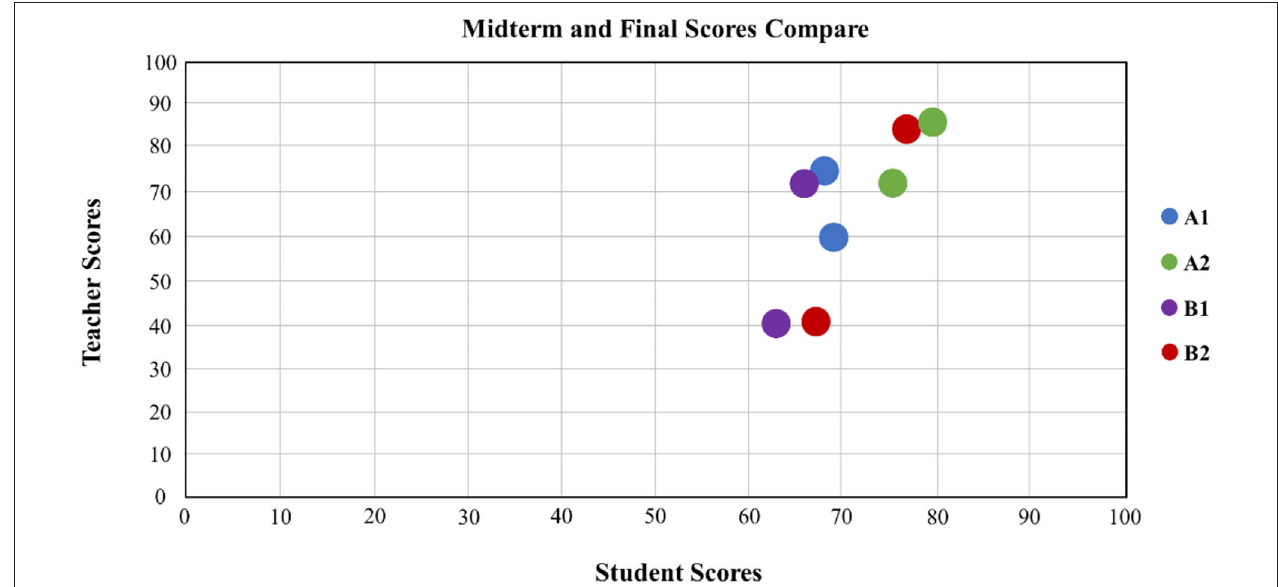
FIGURE 9 | Midterm and final examination score comparison: classes A1, A2, B1, and